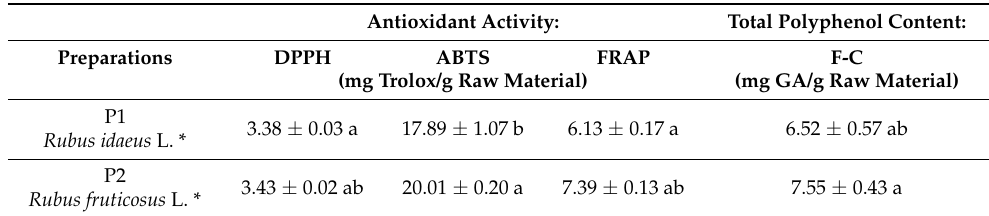
Table 2. Antioxidant activity and total polyphenol content of preparations obtained from the R. idaeus L. and R. fruticosus L.